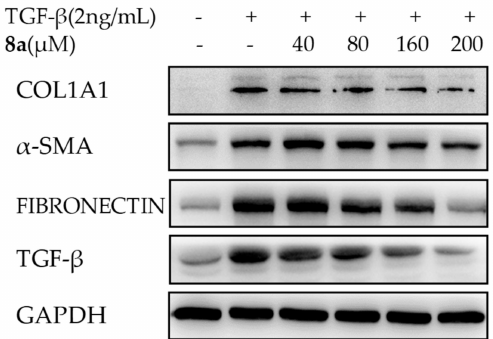
Figure 5. E ff ects of 8a on inhibiting fibrogenic COL1A1, α -SMA, fibronectin and TGF β on the protein level at di ff erent concentrations in LX-2 cells by a western blot assay after a 24-h treatment. The protein expression levels were normalized against